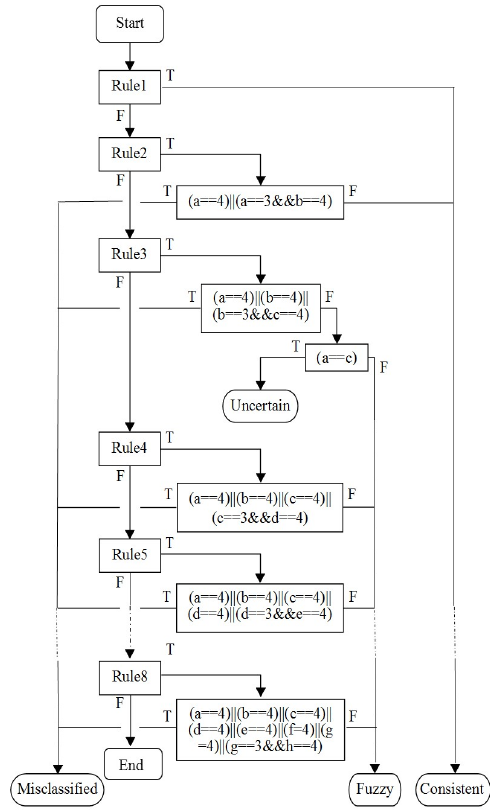
Figure A1. Rationality evaluation rules.